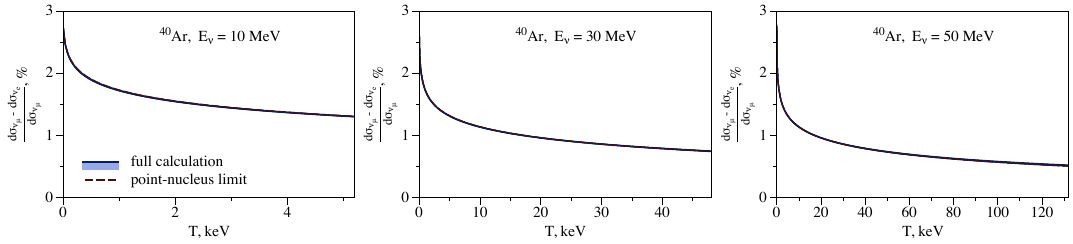
(cid:0) d (cid:1) compared to the point-nucleus σ ν − d σ ν / d σ ν µ e µ